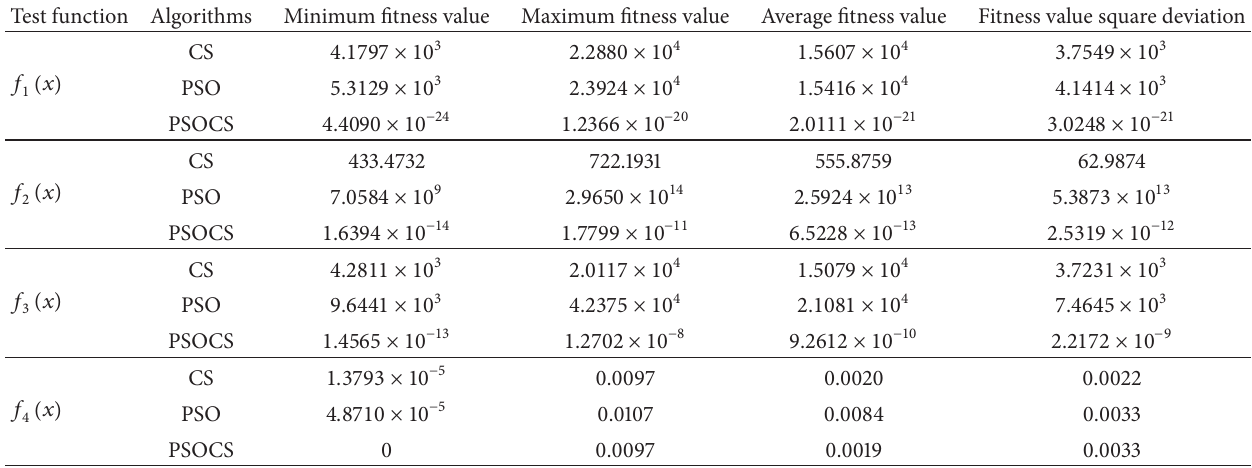
Table 2: Average fitness value of optimization results for PSO, CS, and PSOCS.